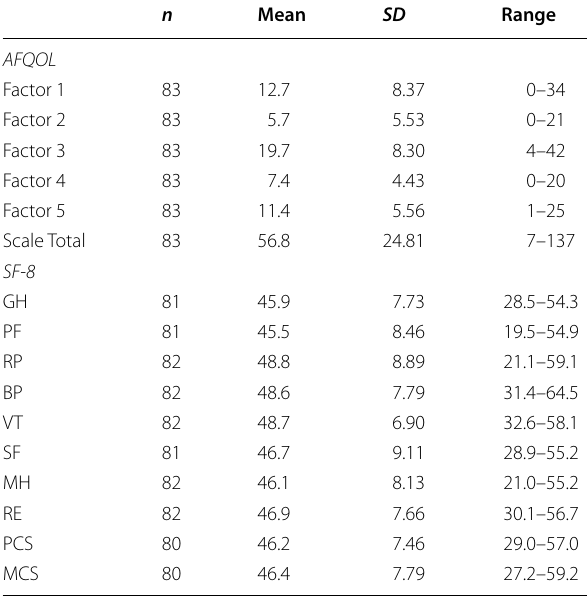
Table 3 Description of factors of the developed scale and SF-8